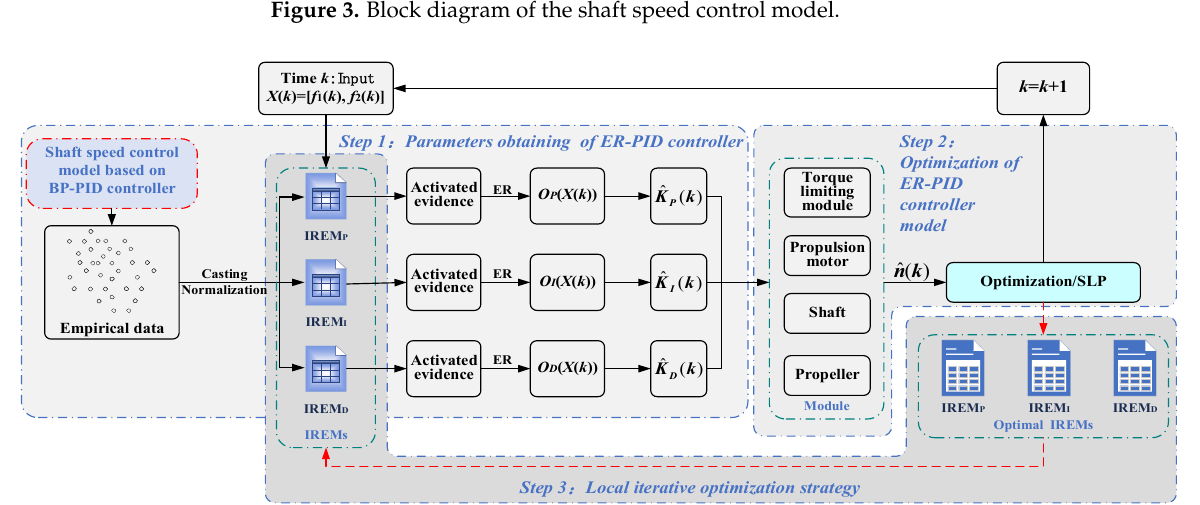
Figure 4. Framework of the shaft speed control model.